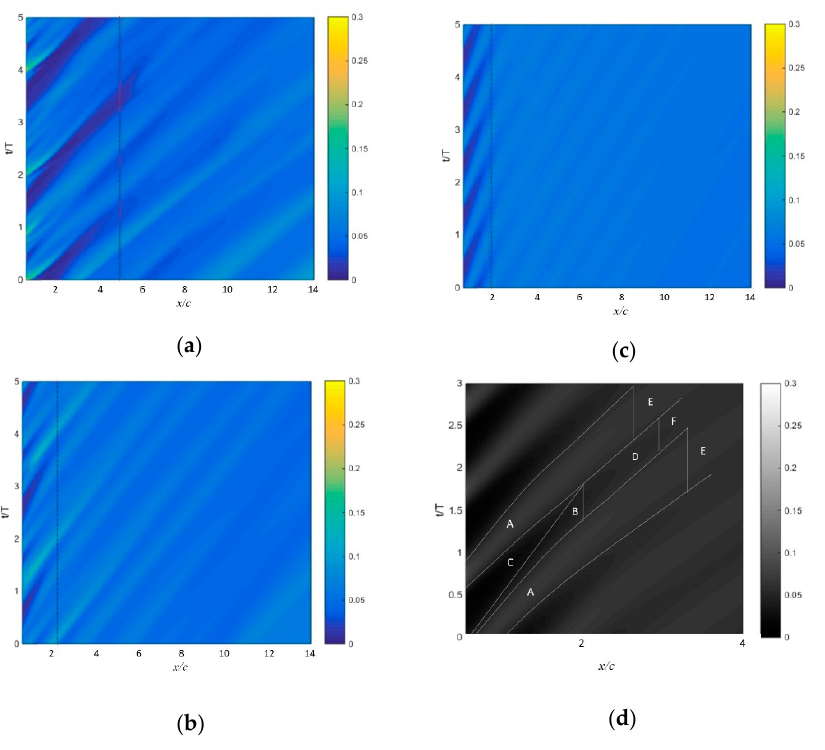
Figure 11. Time-Space diagram of turbulence intensity at y/Ls = 0.25 for different frequency ( a ) f = 20 Hz ( b ) f = 30 Hz ( c ) f = 40 Hz ( d ) schematic of boundary layer states at f = 40 Hz.